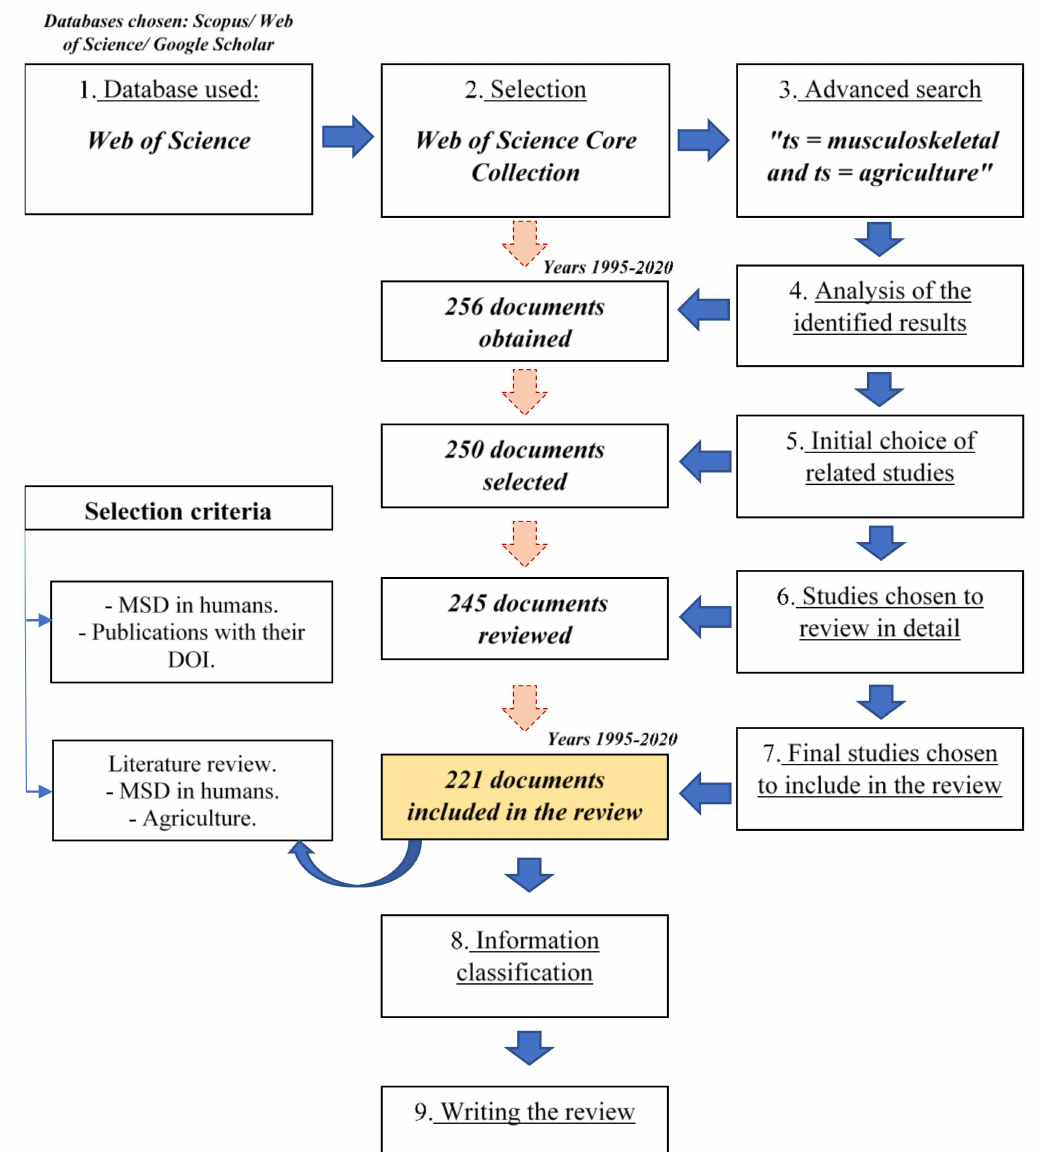
Figure 6. Search